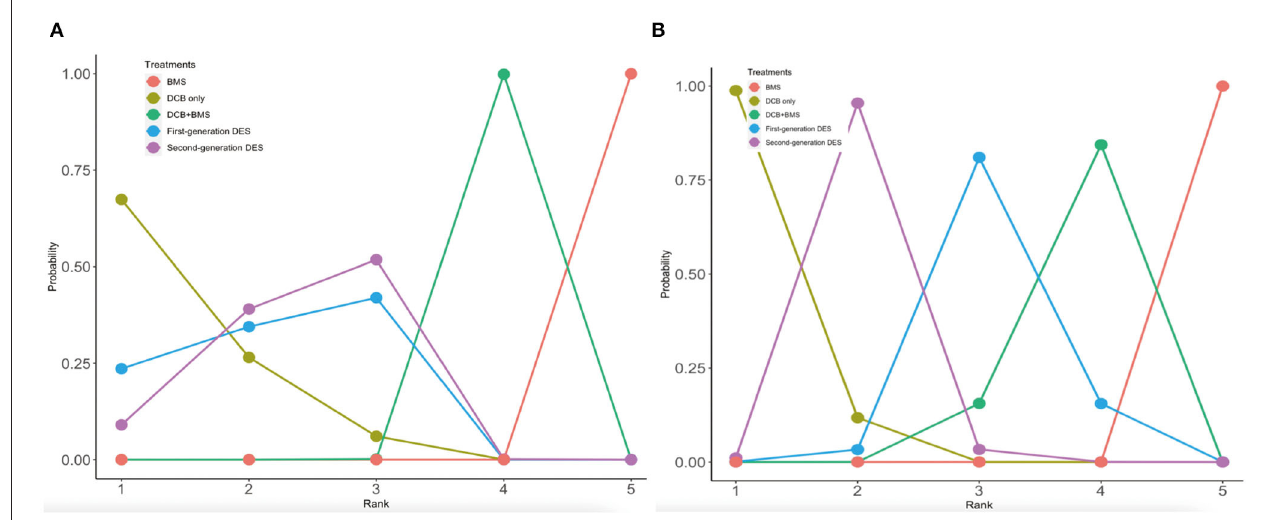
FIGURE 5 | Rankograms on broken line graph from MACE and LLL. (A) MACE; (B) LLL. The 1–5 on X axial refers to the rank from the best to the worst. The number on y axial refers to the probability of rank.